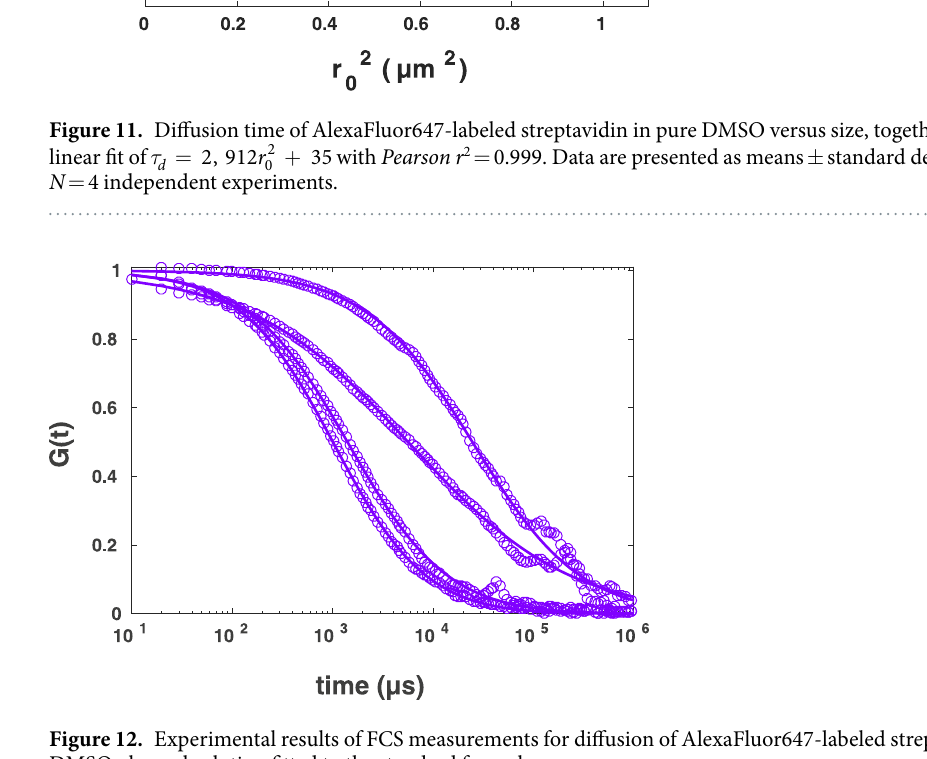
The same procedure has been repeated for the binary mixture of DMSO:glycerol (77%:23%, v/v). Four inde- pendent samples with the same ratio of DMSO and glycerol and 0.5 nM AlexaFluor647-labeled streptavidin were prepared. For each sample we performed two FCS measurements at two different positions. Figure 12 shows the FCS curves of four measurements (one of the two measurements for each sample). A strong variation of diffusion time and exponent of anomalous diffusion was observed, indicationg the heterogeneneity of the system at larger scales. For curves shown in this figure, the exponents of anomalous diffusion were 0.79, 0.91, 0.87 and 0.52 and After analysing this heterogeneity at the diffraction-limited scale using FCS, we also performed the spot vari- ation with post-processing to investigate the existence of nano-scale domains in the diffraction-unlimited detec- tion volume. The post-processed data for smaller spot sizes were shown in Fig. 13. Only one of the measurements (shown in the right panel) shows the linear decrease of the diffusion time with the decreasing of the spot size. Three other sets of data show extreme deviations from the behaviour expected for homogeneous systems: Even the exponents of anomalous diffusion obtained for smaller r 0 deviate considerably from the ones obtained from the experimen- tal confocal FCS data. Most of them tend to unity (normal diffusion) for smaller spot sizes, in some cases the fit indicates α > 1, which, however, is probably an artefact due to an inappropriate fit function 11 . In order to apply the diffusion law analysis, one can not simply average the diffusion times resulting from the different exponents of anomalous diffusion, different exponents for each initial measurement and the spot vari- ated data. Taking into account a binary nature of the system, we performed two-component fits for the all original and spot variated FCS curves. Although the two components were suboptimal, requiring higher number of com- ponents, our analysis indicates the existence of the slow component with the diffusion time of 31,907 ± 2,726 μ s ,